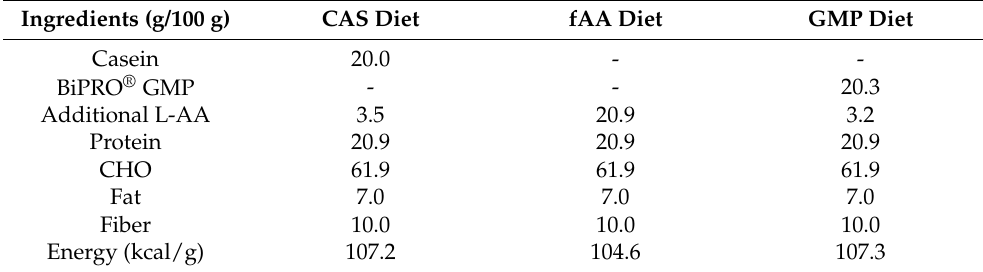
Table 2. Composition of the control diet (CAS diet) and the experimental diets (L-AA diet and GMP